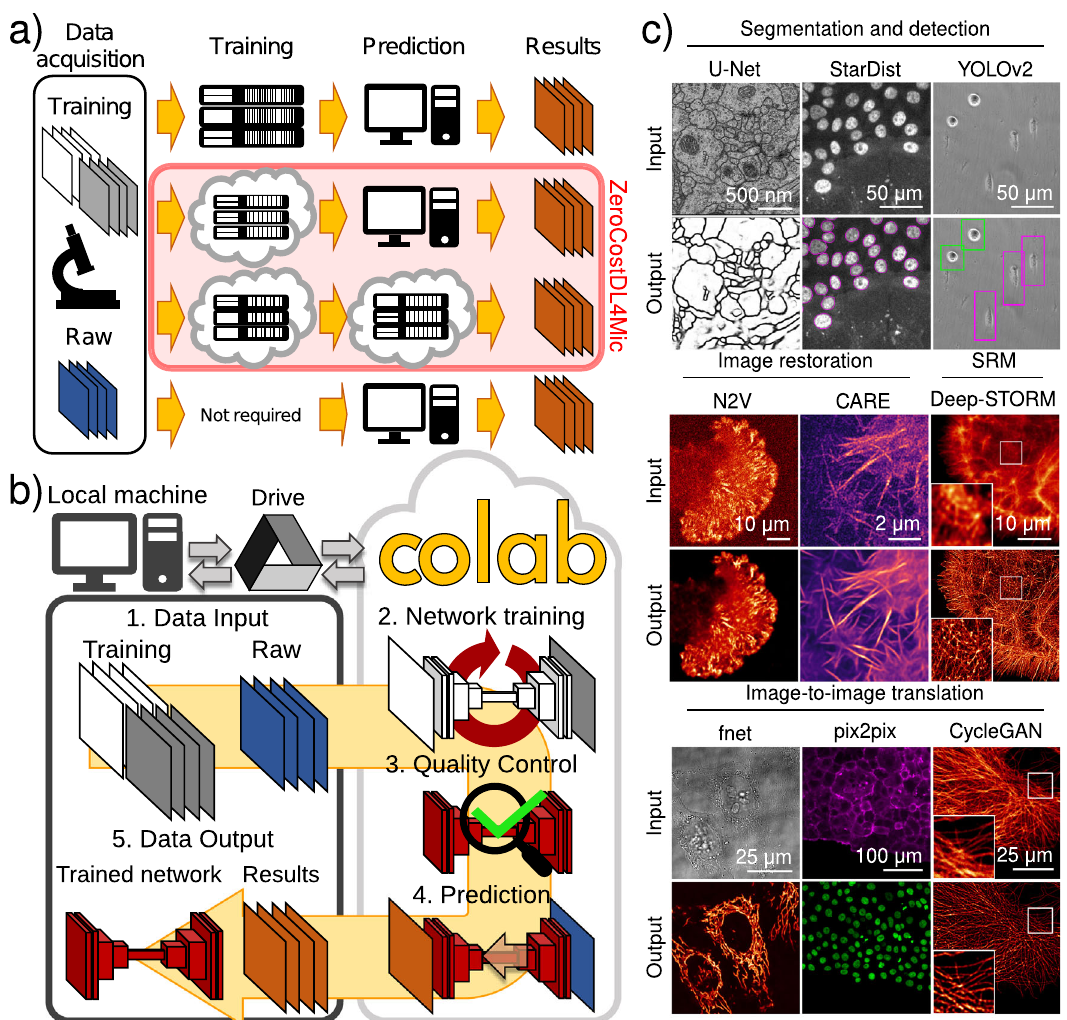
Fig. 1 Using DL for microscopy. a Paths to exploiting DL. Training on local servers and inference on local machines (or servers) ( fi rst row), cloud-based training and local inference (second row), cloud-based training and inference (third row) and pretrained networks on standard machines (fourth row). b Overview of ZeroCostDL4Mic. The work fl ow of ZeroCostDL4Mic, featuring data transfer through Google Drive, training, quality control and prediction via Google Colab. After running a network, trained models, quality control and prediction results can then be downloaded to the user ’ s machine. c Overview of the bioimage analysis tasks currently implemented within the ZeroCostDL4Mic platform. Datasets from top left to bottom right: U-Net — ISBI 2012 Neuronal Segmentation Dataset 78,79 , StarDist — nuclear marker (SiR-DNA) in DCIS.COM cells, YOLOv2 — bright fi eld in MDA-MB-231 cells, N2V —